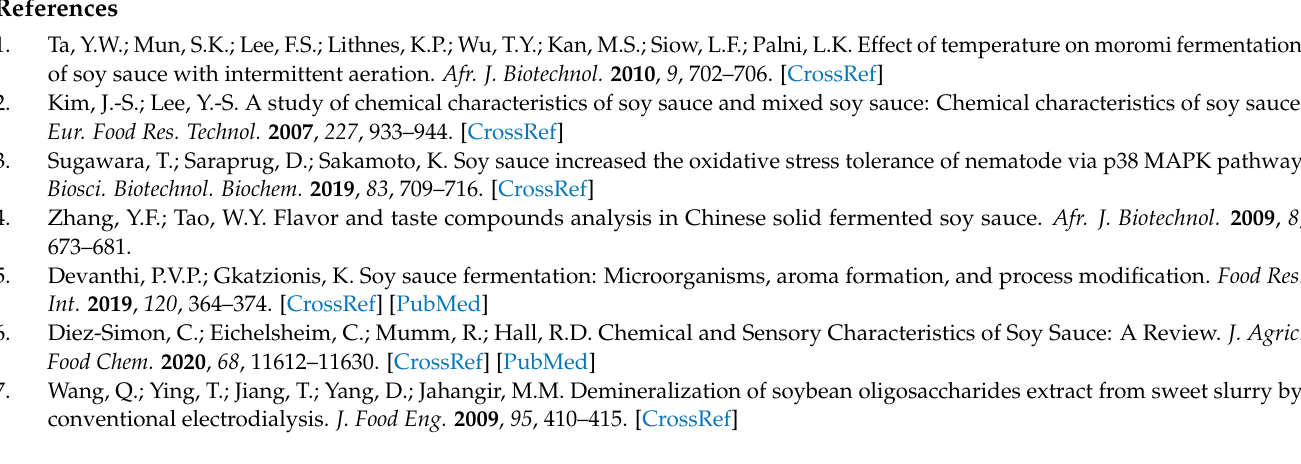
(B) the correlation between water flux and current density. Figure S2. (A) Voltage changes as a function of time at the current density of 25, 50, 75, 100, 125, and 150 A/m2. (B) The relationship between voltage measured at the end of the experiment and the applied current density. Figure S3. The correlation between the conductivity and the NaCl concentration. Figure S4. The pH change in the concentrate compartment during the desalination process. Figure S5. Reverse current density and resistance diagram. Figure S6. Desalination degree as a function of current density in the soy sauce desalination ex-periments. Table S1. Charge state of amino